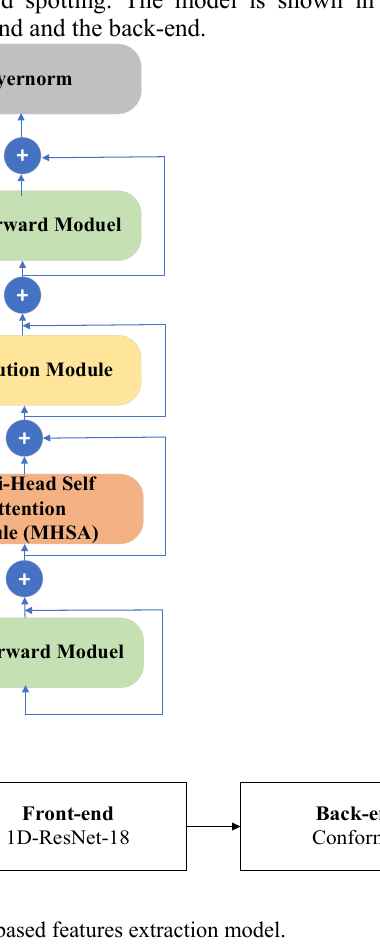
Fig. 2. Convolution-augmented Transformers based features extraction